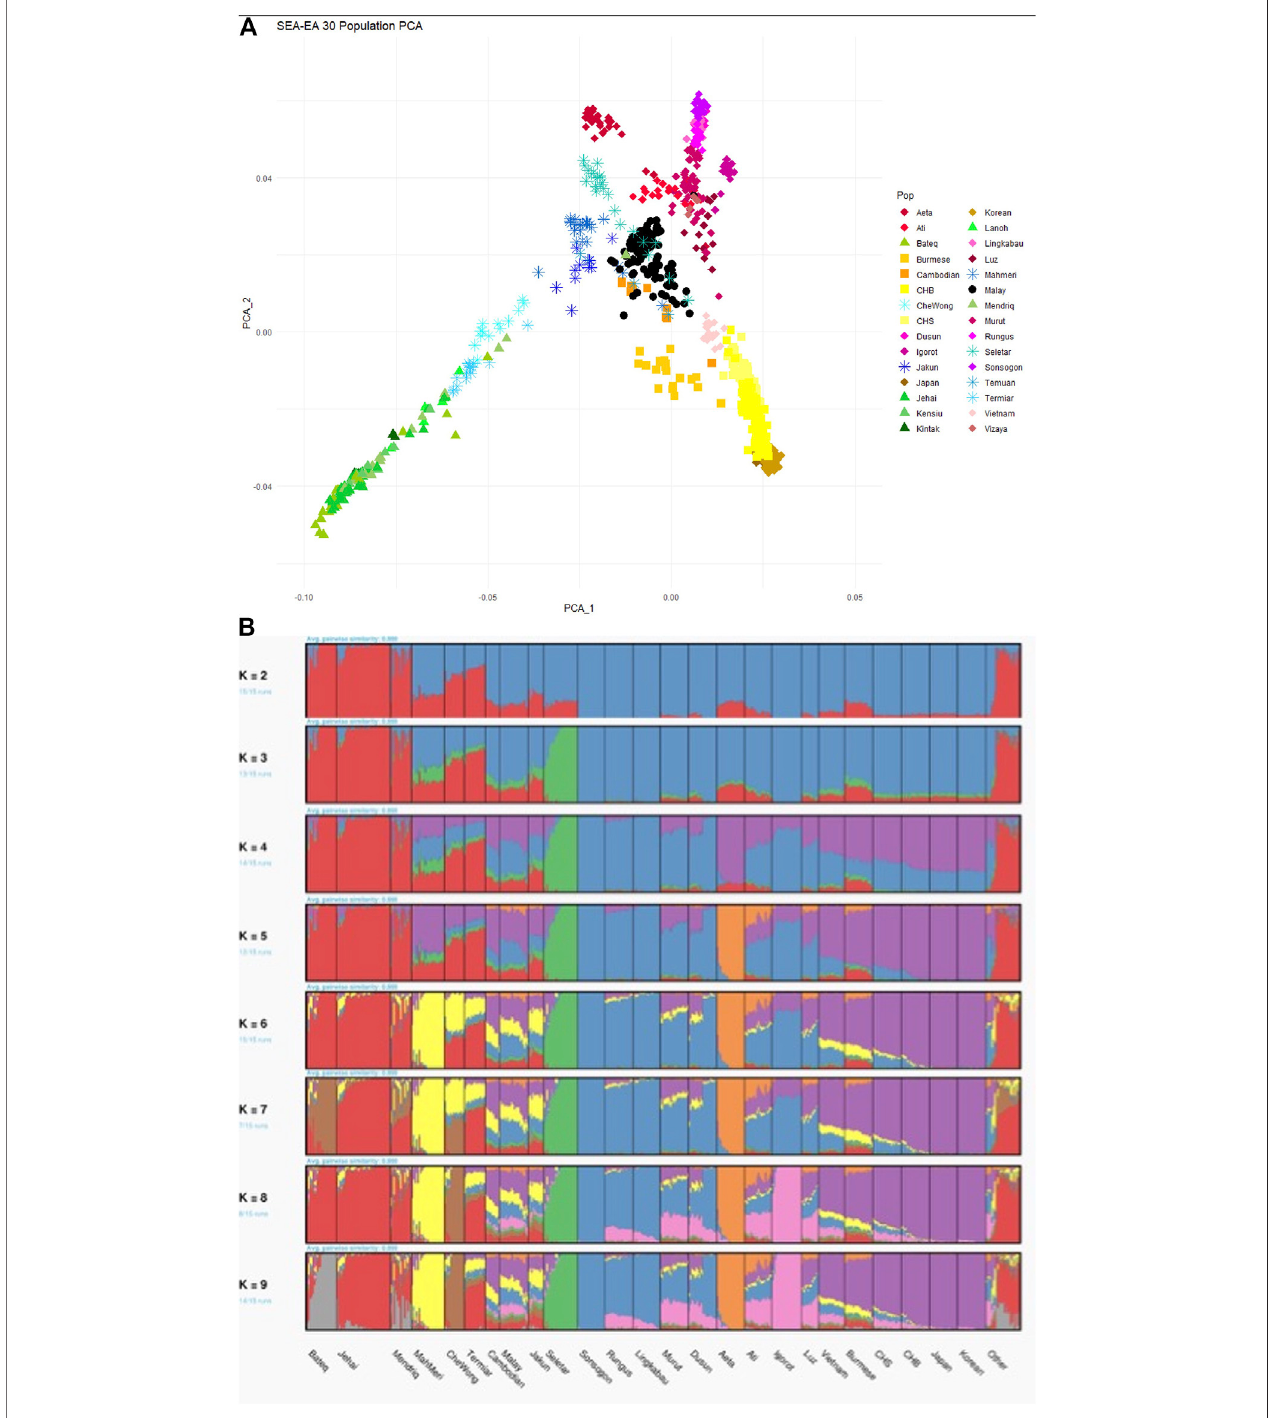
FIGURE 3 | PCA and ADMIXTURE analysis between the Malay (MAS) and HGDP-Cambodian populations. (A) Both MAS and HGDP-Cambodian are clustered close to each other in PC1 and PC2. (B) In ADMIXTURE analysis, the ancestral components for the MAS and HGDP-Cambodian are indistinguishable.